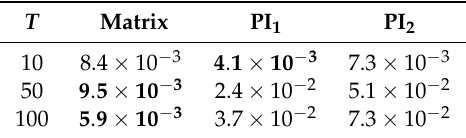
Table 4. Comparison of execution time for the matrix approach and the product integration (PI) methods for computing the approximate solution at T of Equation